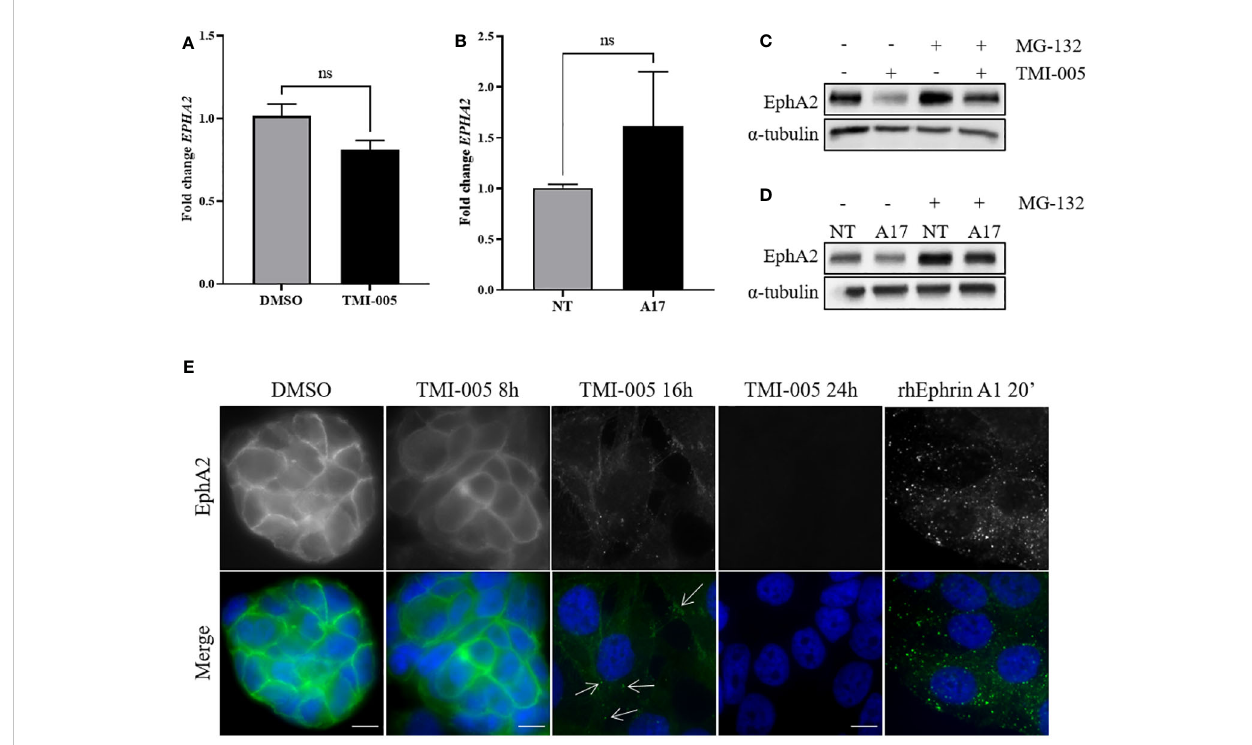
FIGURE 4 ADAM17 activity protects EphA2 from endocytosis and proteasomal degradation. (A) TMI-005 (25µM) or (B) ADAM17 downregulation with shRNA directed against ADAM17 (A17) do not signi fi cantly alter EphA2 gene expression. Concurrent treatment with MG-132 (1µM) rescues (C) TMI-005 and (D) A17-induced reduction of total EphA2 protein levels. Cells were treated with MG-132/TMI-005 for 24h. (A) and (B) Bar graphs represent average EphA2 mRNA expression relative to the housekeeping control GAPDH ± SEM from two independent biological replicates; ns, non-signi fi cant. (E) The subcellular localization of EphA2 after TMI-005 or upon cellular incubation with rhEphrin-A1 Fc (1µg/ml) was assessed by immuno fl uorescence microscope. White arrows indicate EphA2 foci. Scale bar = 10µM. These fi gures are representative of several independent experiments. ns, not signi fi